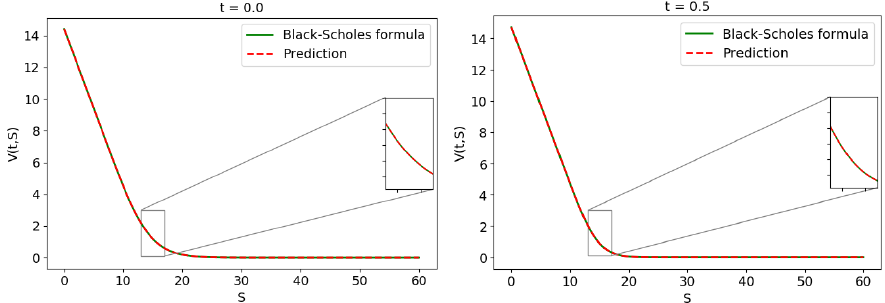
Figure 1. European put option for different time instances, t = 0, t = 0.5, with λ = 0.5.